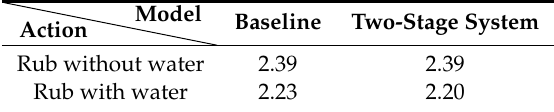
Table 8. Two-stage system: Average mis-prediction in seconds.